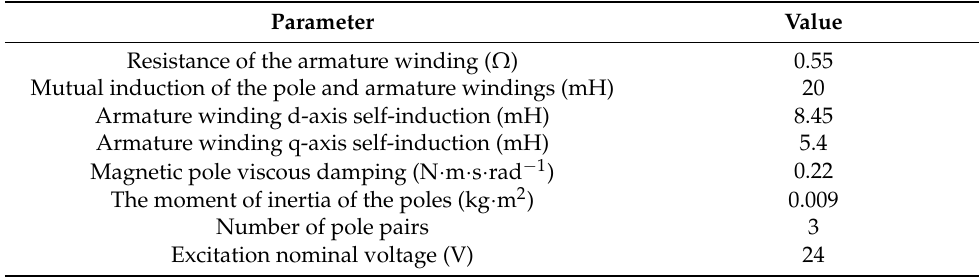
The moment of inertia of the poles (kg · m 2